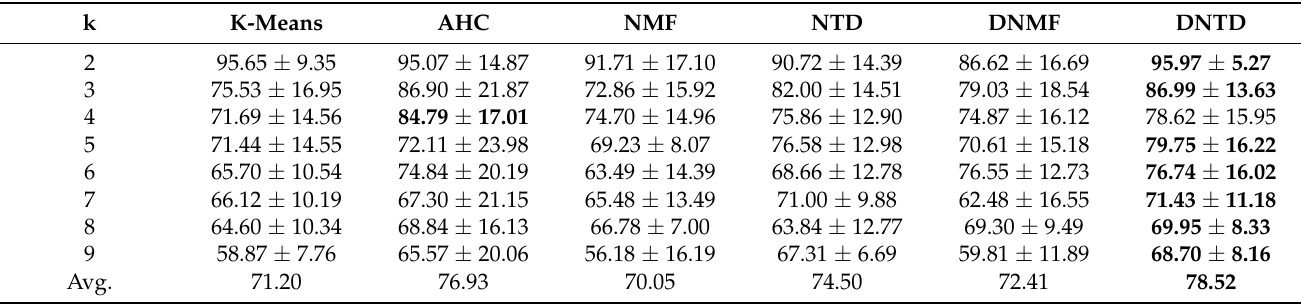
Table 3. AC (%) ± standard deviation (%) of different algorithms on COIL20 dataset.